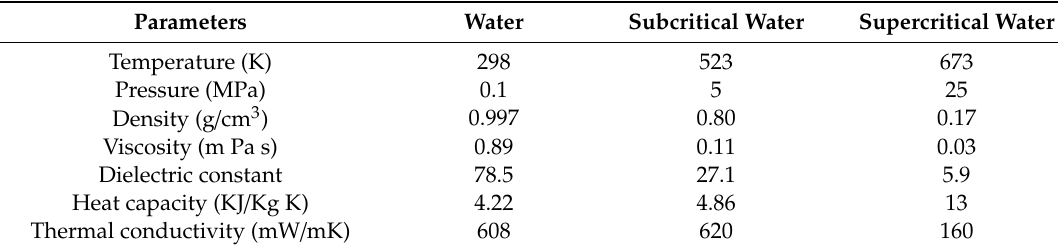
Table 2. Characteristics of water in di ff erent temperature ranges.